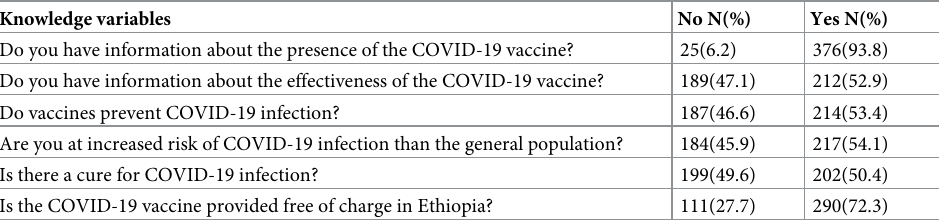
Table 2. Knowledge about the COVID-19 vaccine.